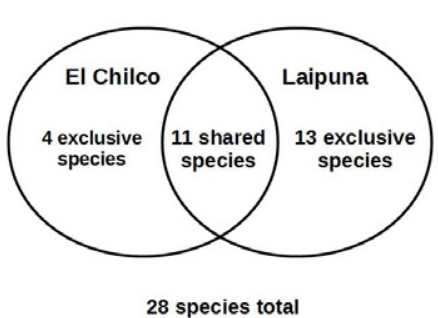
Fig 1 . Number of species collected for each subfamily at both sites.